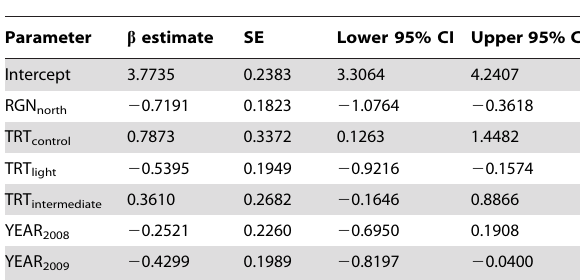
Table 3. Parameter estimates (on logit-link scale), standard errors (SE), and 95% confidence intervals (CI) from top-ranked model (RGN + YEAR + TRT) estimating daily survival rate of cerulean warbler